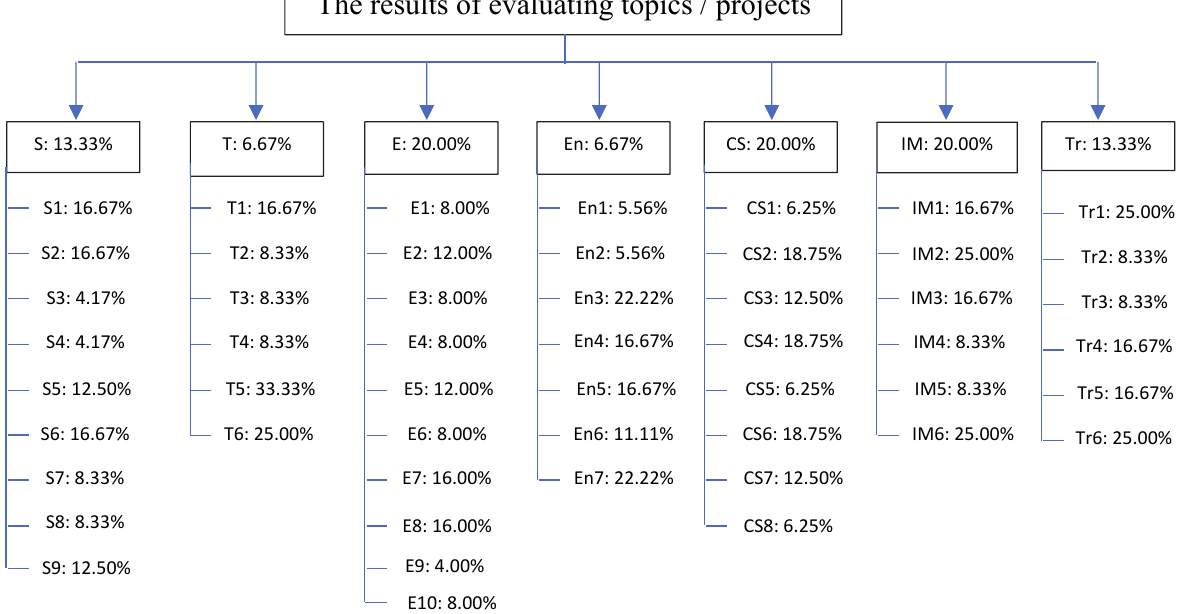
Fig. 5. Weight of each criterion for evaluating socio-economic efficiency of social sciences and humanities topics